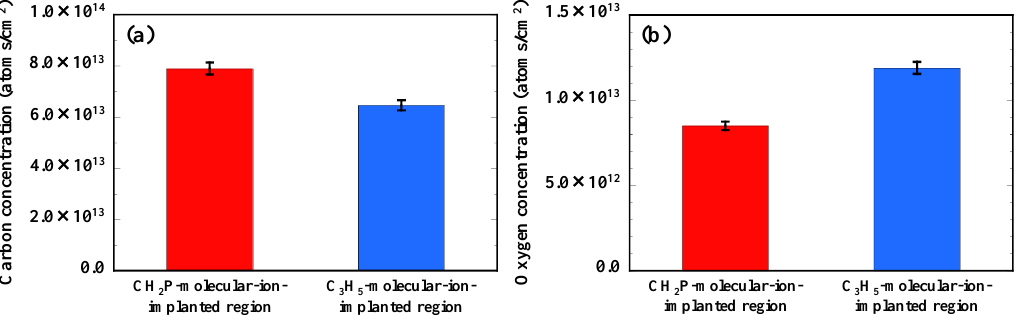
Figure 10. ( a ) Carbon and ( b ) oxygen concentrations localized in CH 2 P- and C 3 H 5 -molecular-ion- implanted regions after epitaxial growth.